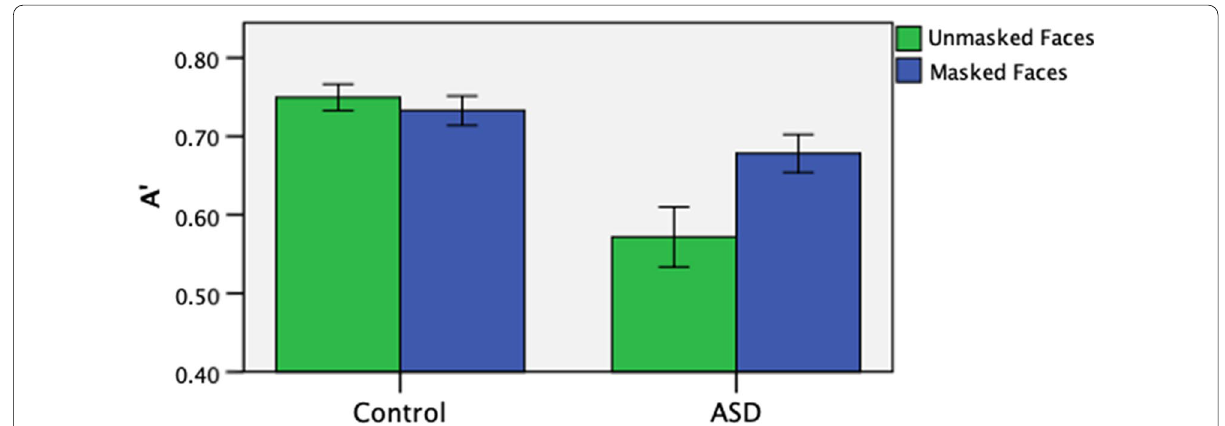
Fig. 4 A’ in the recognition of unmasked and masked faces in participants with and without